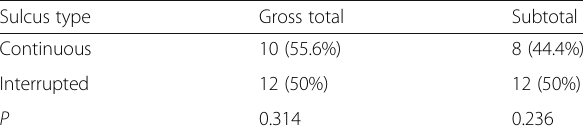
Table 3 Relation between sulcal dissection at and near the motor cortex and functional preservation Extent of resection Preservation of function Deterioration of functions